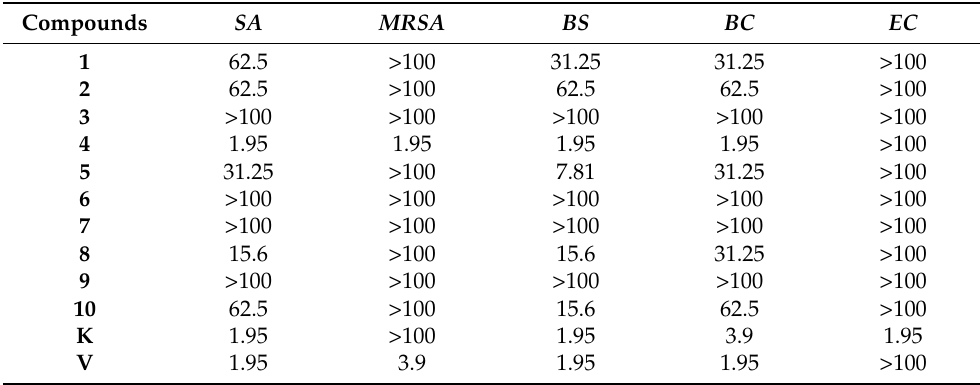
Table 3. Antibacterial activity of compounds 1 – 10 (MIC, µ g/mL).